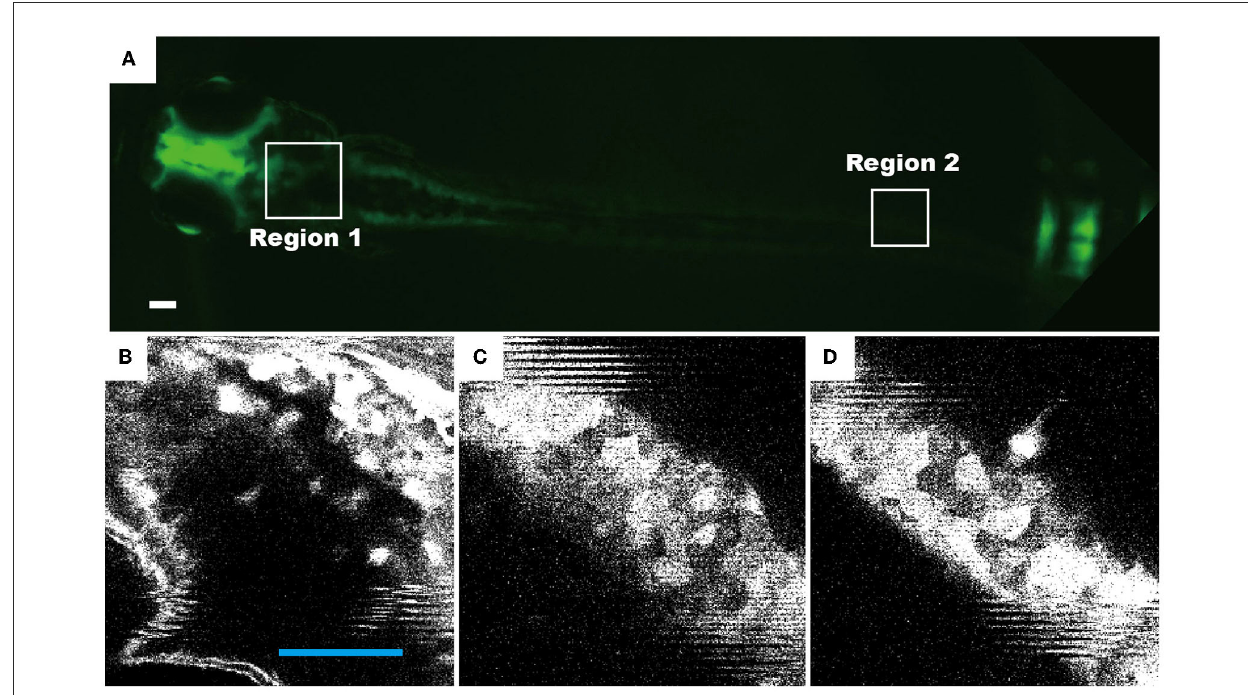
FIGURE6 Representative fluorescence images of live zebrafish, which were transfected and maintained in a droplet of four recirculating flow patterns. The neuronal cells of transgenic zebrafish permanently express the HuC-GFP minigene (10.7kb). Fluorescence images of 72 hpf living zebrafish: (A) as a whole fish, (B) the head region [region 1 as indicated in (A) ], and (C, D) the tail region (region 2). Scale bars in all figures denote 100 µ